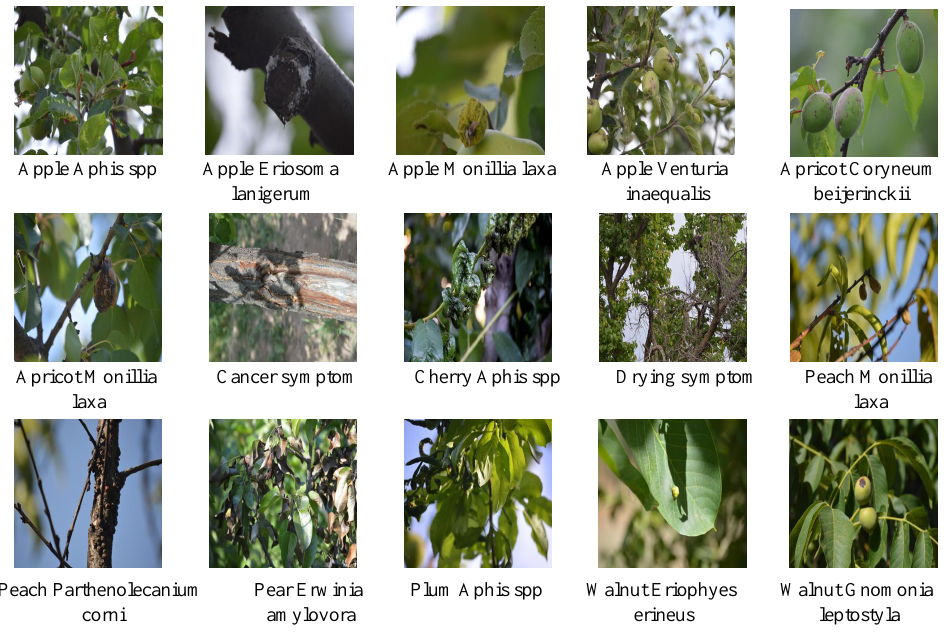
Figure 12. Example images from Turkey Plant dataset; one image for each species. Table 10. Classification accuracy (%) comparison on Turkey Plant dataset with identical settings.